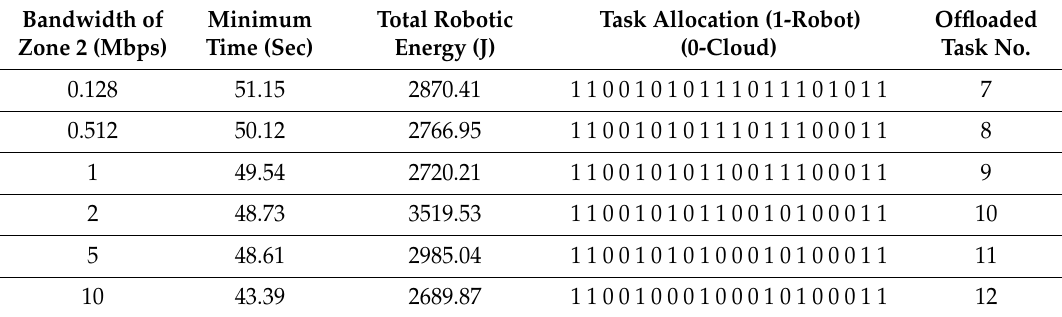
Table 5. Impact of bandwidth change on task offloading.